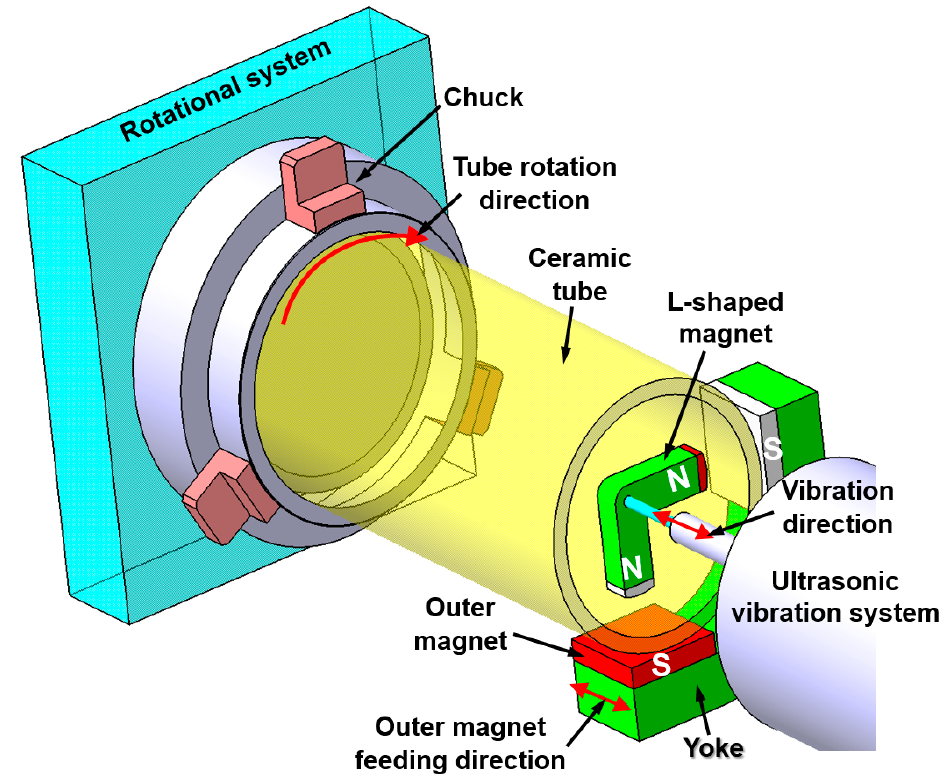
Figure 6. Schematic of the internal MAF process for the surface finishing of alumina ceramic tube using an ultrasonic vibration L-shaped magnet, redrawn from Yun et al. [55].